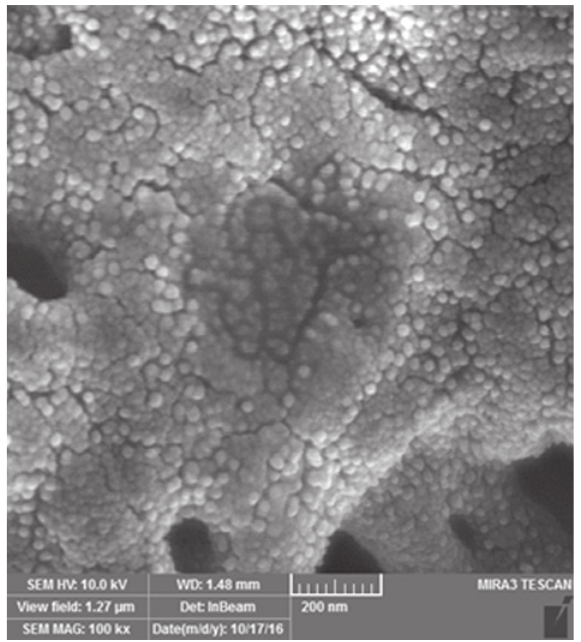
Figure 9: Zone of inhibition produced by ZnO NPs (bottom disc) as compared to the zinc nitrate (top disc) against Staphylococcus aureus